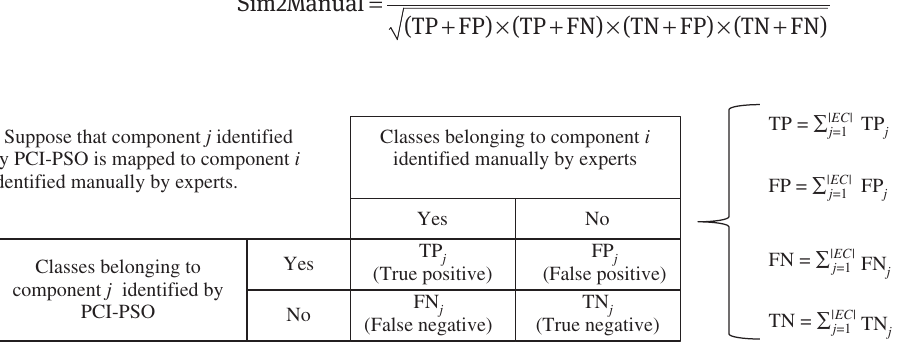
Figure 3: Definitions of TP, FP, FN, and